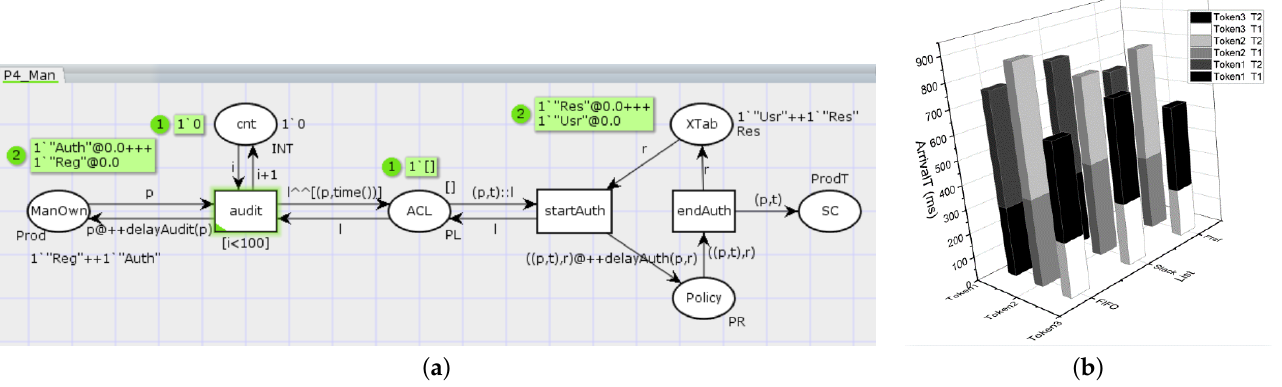
Figure 4. Behavior and metrics statistics for management service. ( a ) CPN Model. ( b ) Data